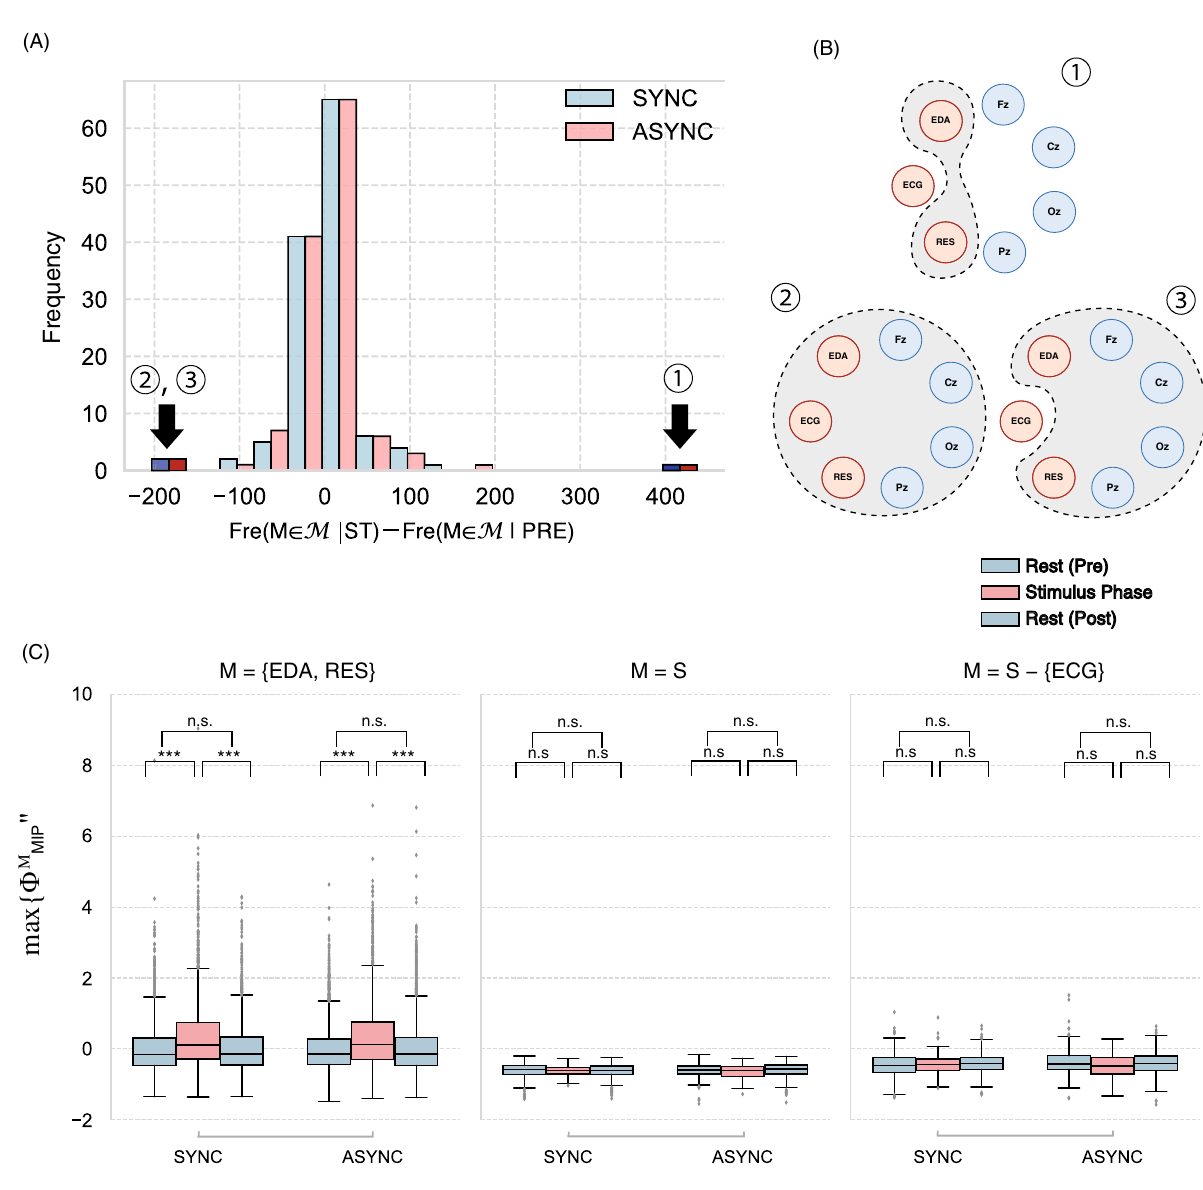
M } frequency for pre- and intra-stimuli: Figure 4. ( A ) Histogram of the difference in the max M ∈ M { (cid:31) M M MIP | ST ) − Fr ( M ∈ | PRE ) . Because many main complexes exist, we analysed only the outliers (indexed Fr ( M ∈ 1, 2, 3). Blue (red) bars show the frequency in the synchronous (asynchronous) condition. ( B ) Image of the main M } complex for the system S . {EDA, RES}, S , and S -{ECG} are the three greatest differences. ( C ) max M ∈ M { (cid:31) MIP for each main complex. Only for M = {EDA, RES} does (cid:31) MIP rises significantly during the stimulus. The other two values are negative throughout the three phases ( ∗ p < 0.05 , ∗ ∗ p < 0.01 , ∗ ∗ ∗ p < 0.005 . See Tables S4 and S5 for other parameter